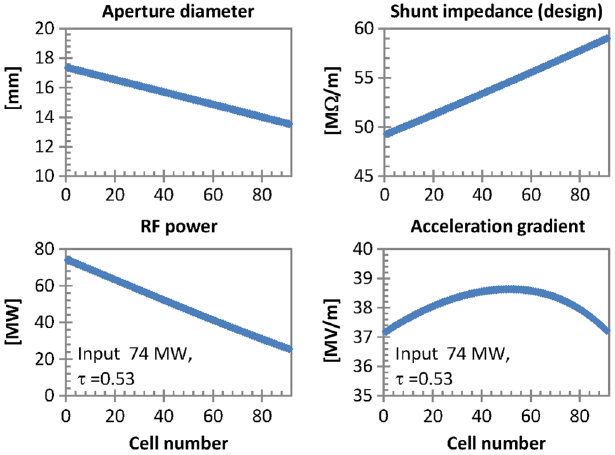
FIG. 5. Parameters of each accelerator cell; aperture diameter, designed shunt impedance and the computed rf power and acceleration gradient with an input power of 74 MW, which yields an average acceleration gradient of 38 MV = m.